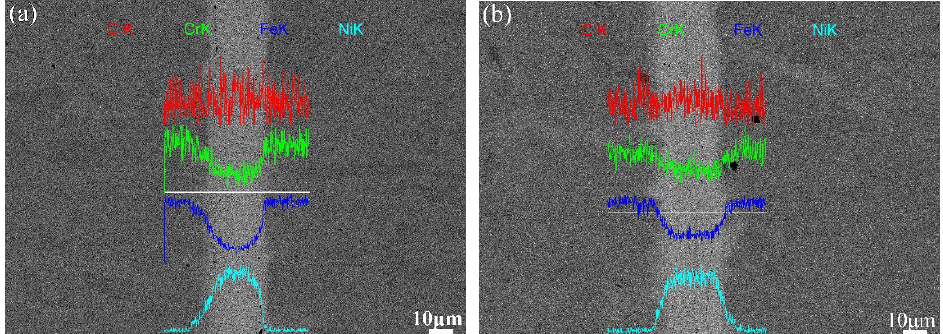
Figure 3. Back-scattered electron (BSE) scanning electron microscopy (SEM) micrographs of the joint interface with qualitative line analysis: ( a ) prior to tempering treatment and ( b ) subject to tempering treatment. The white line indicates the energy dispersive X-ray spectroscopy (EDS) line scanning area across the joint.